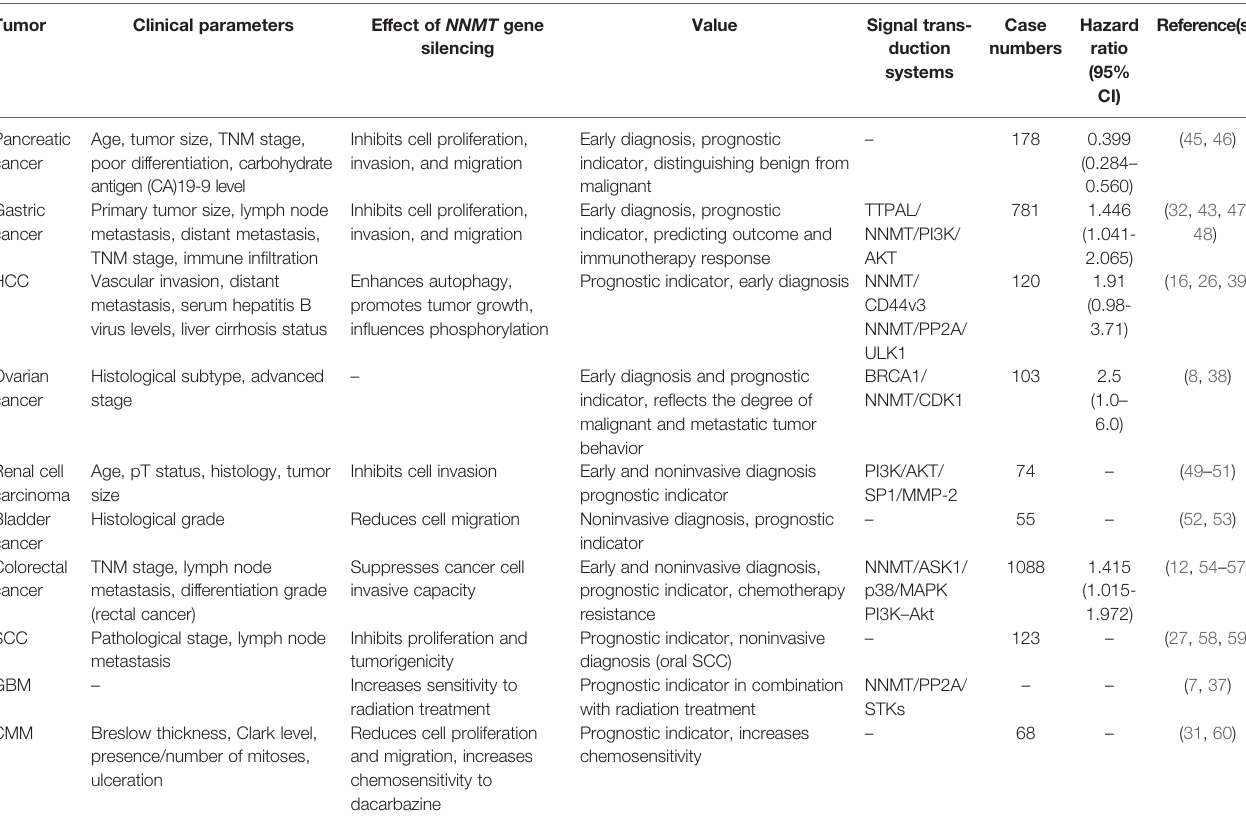
TABLE 1 | Summary of the clinical value of NNMT in